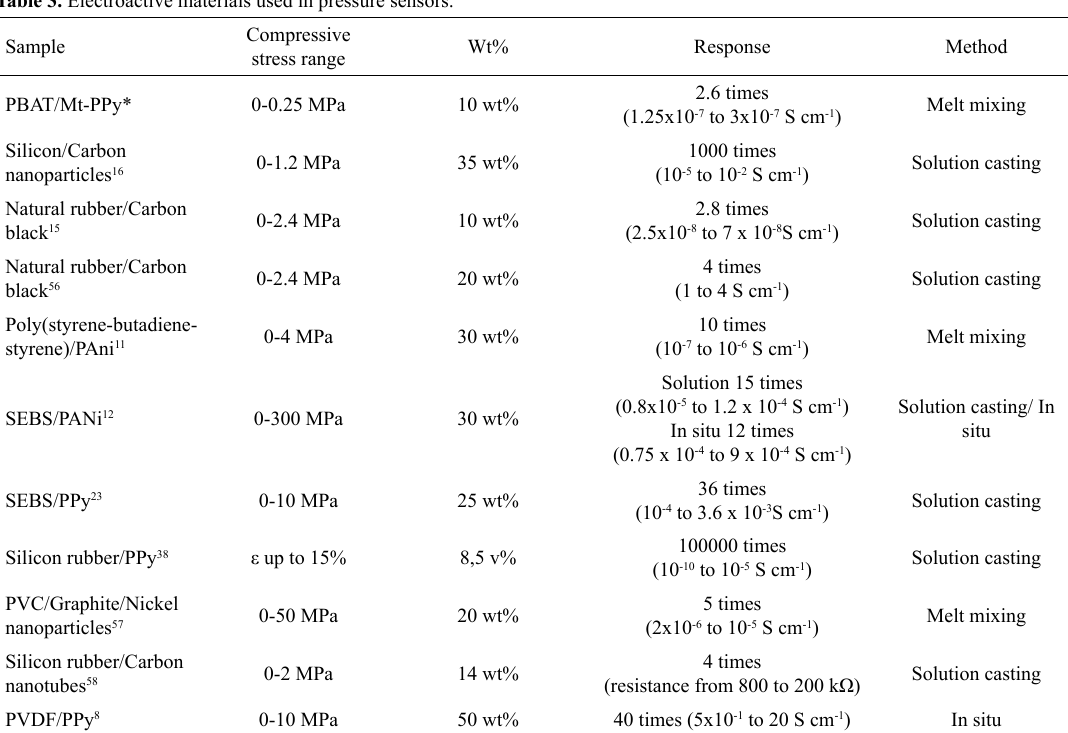
Table 3. Electroactive materials used in pressure